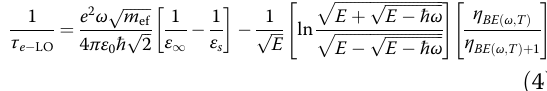
2 ω 1 ¼ e τ e (cid:2) LO where E represents the energy above the CBM, m electron effective mass, η equilibrium population at T (temperature) with phonon frequency ω , ε 1 and ε s are the dielectric constants at low- and high-frequency (static) constants. The same equation can be written for the hole cooling process in the valence band. Thus, the energy relaxation rate is given by d E (cid:1) h ω by neglecting the re-absorption of the phonons. The τ e (cid:2) LO